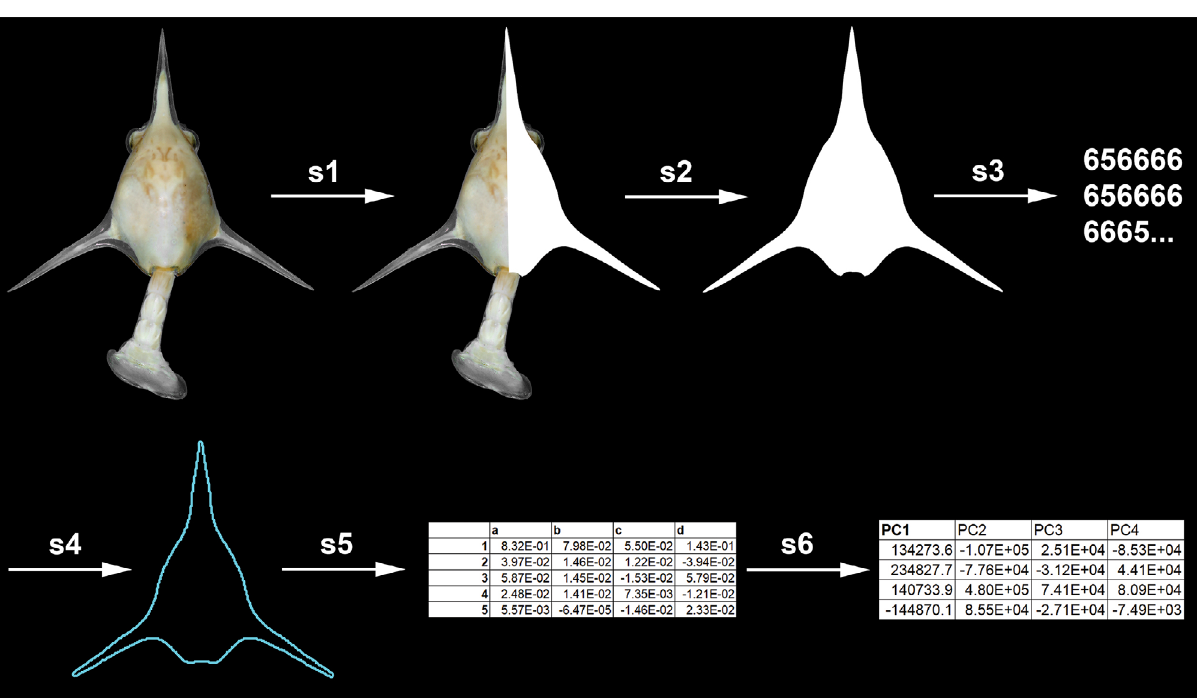
Figure 2. Schematic figure of data generation process. s1: Reconstructing one half of the shield of a specimen; s2: duplicating, mirroring, and removing background; s3: chain coding the shield; s4: checking of graphical interpretation of chain code for accuracy; s5: transforming chain code into elliptic Fourier descriptor; s6: principal component analysis of elliptic Fourier descriptors of all